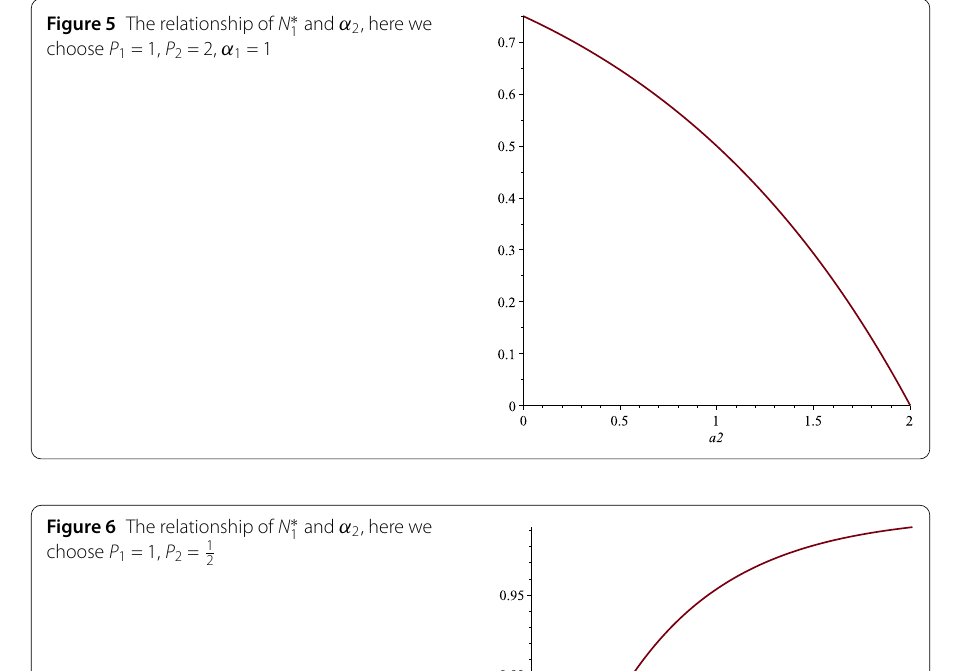
Figure 6 The relationship of N ∗ 1 and α 2 , here we choose P